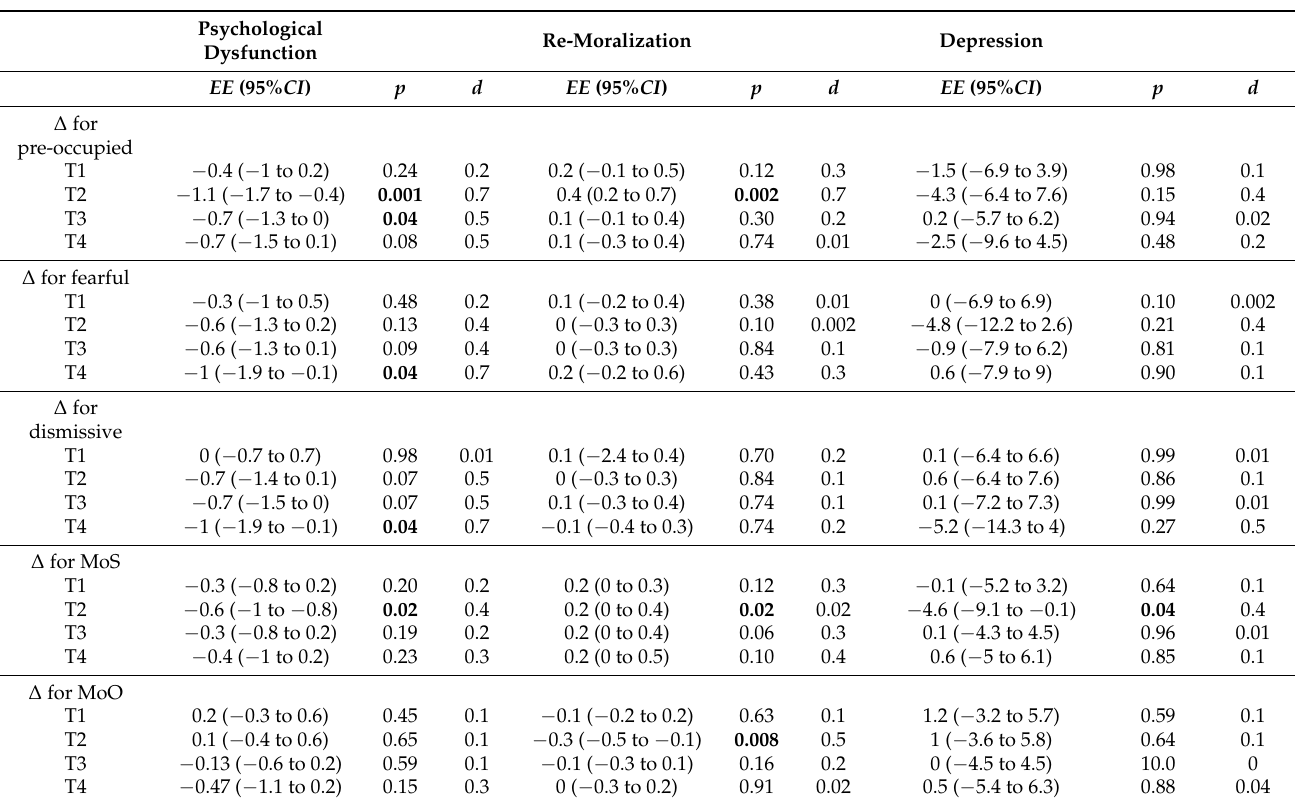
Table 6. Results for mixed models with attachment style and models of self–others in Equine-assisted Short-term Psychodynamic Psychotherapy (ESTPP). Differences in scores are presented as estimated effect (95% CI), p -value, and standardized effect-size d